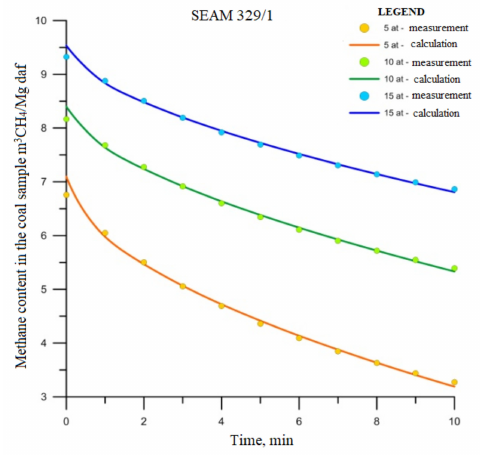
Figure 3. Isotherm of desorption (seam 329/1).